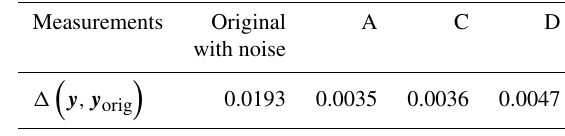
Table A1. Forward model